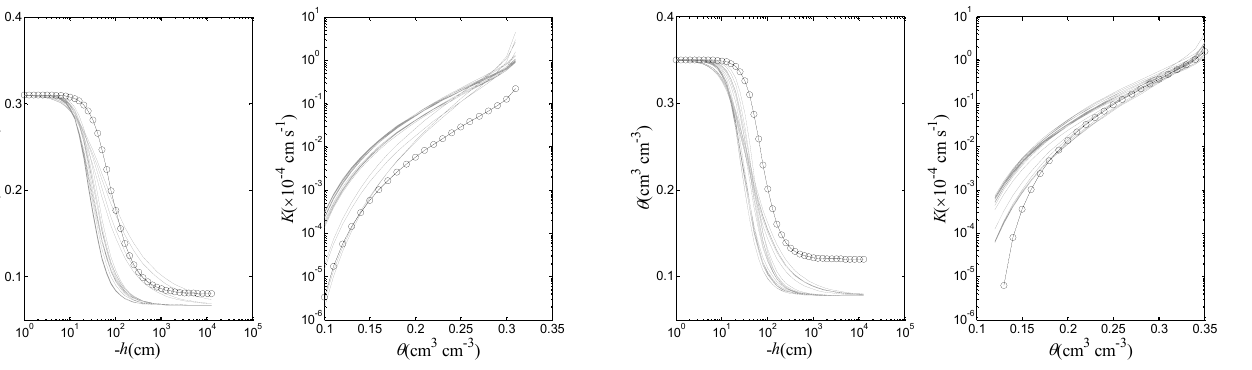
Figure 5. Comparison of the 18 (corresponding to 3 observation depths times 6 initial parameter sets) soil water retention curves θ (h), and hydraulic conductivity functions, K( θ) , using the con- verging parameters for GB1 (grey solid lines). The solid lines with markers indicate the corresponding functions defined with the pa- rameters found by Romano and Santini (1999). Note that in this study θ s =0.35cm 3 cm − 3 and θ r =0.08cm 3 cm − 3 , while Romano and Santini (1999) assumed θ s =0.348cm 3 cm − 3 and θ r =0.12cm 3 cm − 3 .